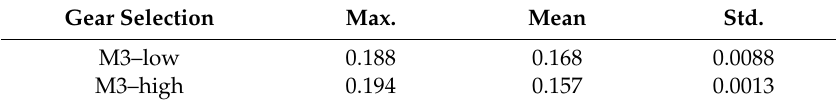
Table 4. Descriptive statistics of tillage depth (m) at di ff erent levels of gear selection.